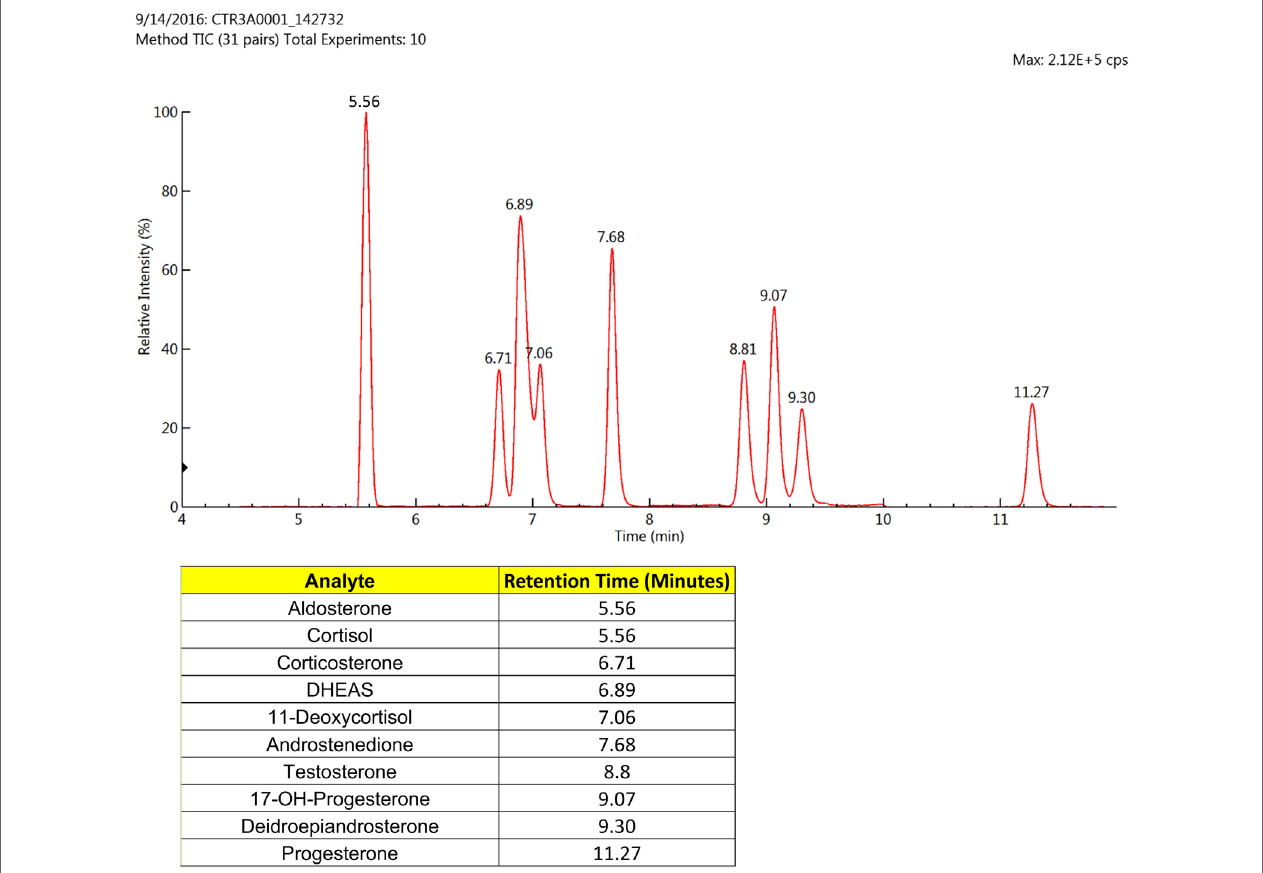
FigUre 1 | Liquid chromatographic (LC) profiles obtained using the standards for the 10 selected steroids (20 µL) that were subjected to mass spectrometry (MS)/ MS-MRM. Only two of the analytes eluted at the same time, but these were easily distinguished by the